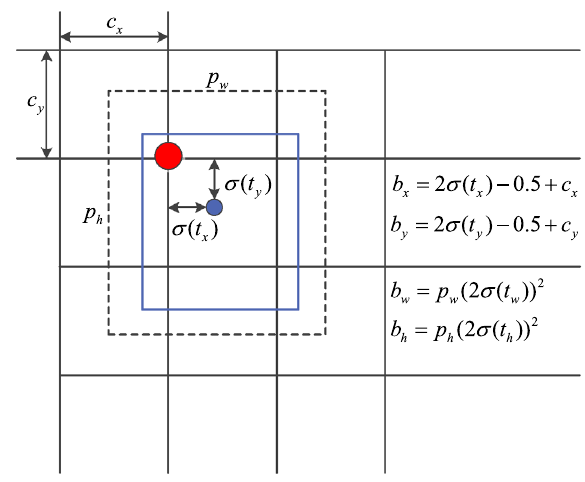
Figure 5. Target box regression schematic diagram.